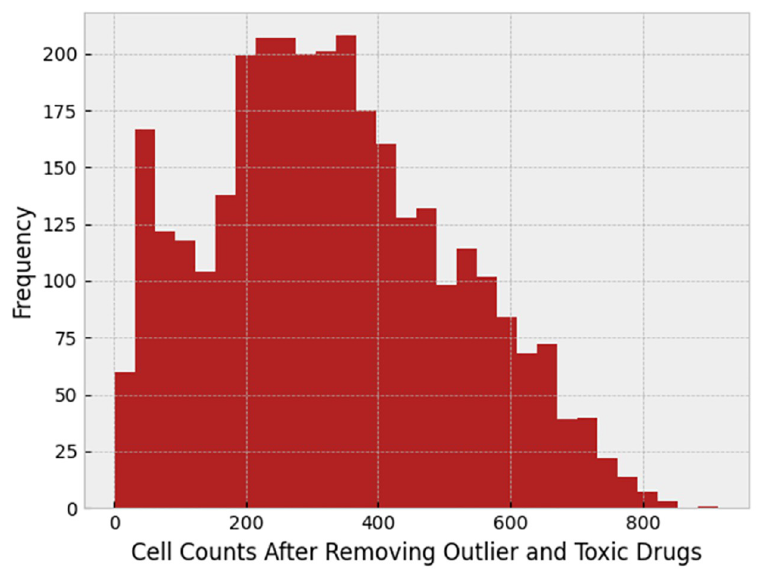
Fig 6. Histogram of the cell count after removing toxic